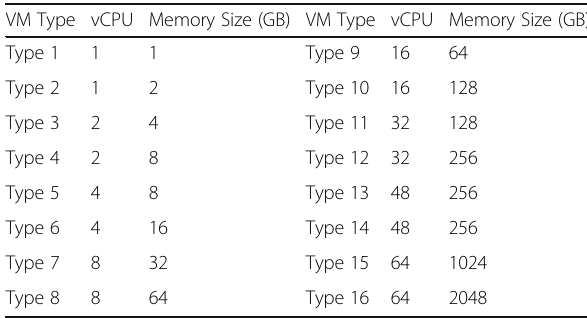
Table 2 Virtual machine types of instances